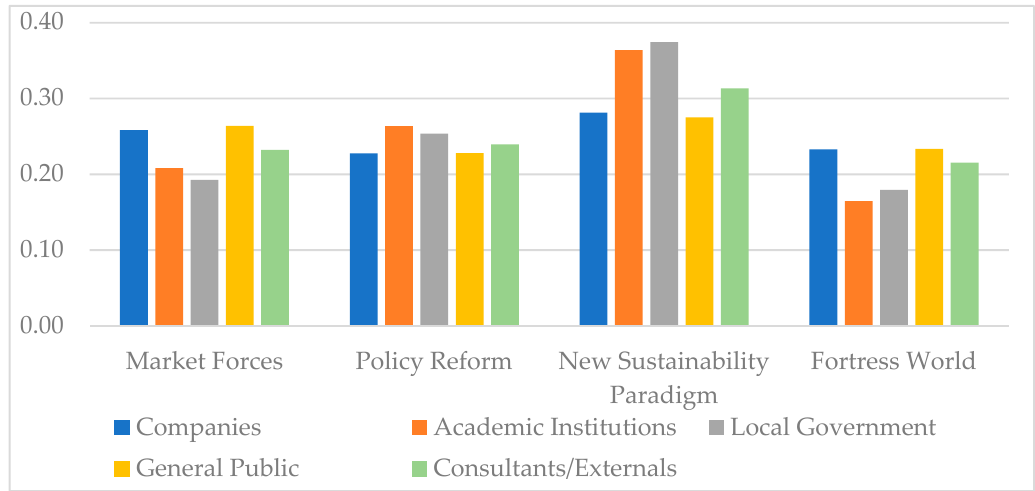
Figure 5. Preferability indexes for the CE scenarios for each stakeholder.